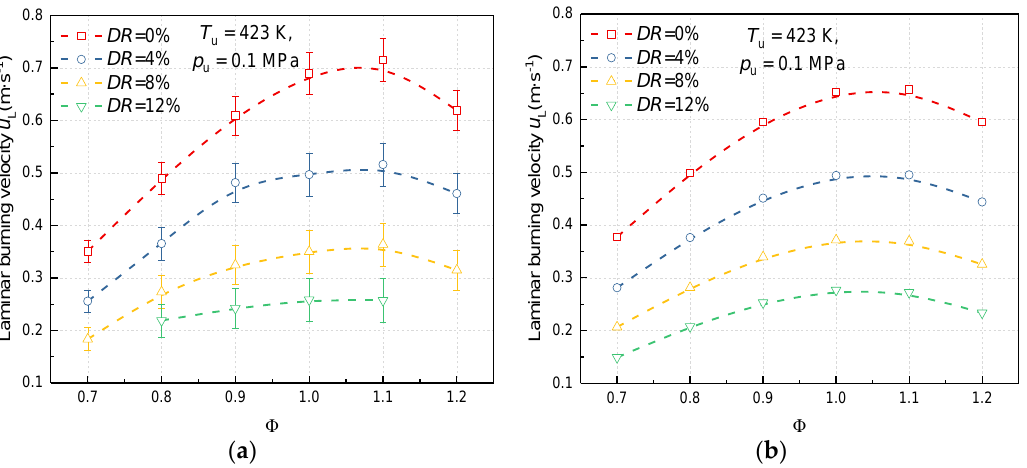
Figure 6. Laminar burning velocities under different dilution rates (initial temperature of 423 K, initial pressure of 0.1 MPa). ( a ) From Schlieren; ( b ) From Chemkin.